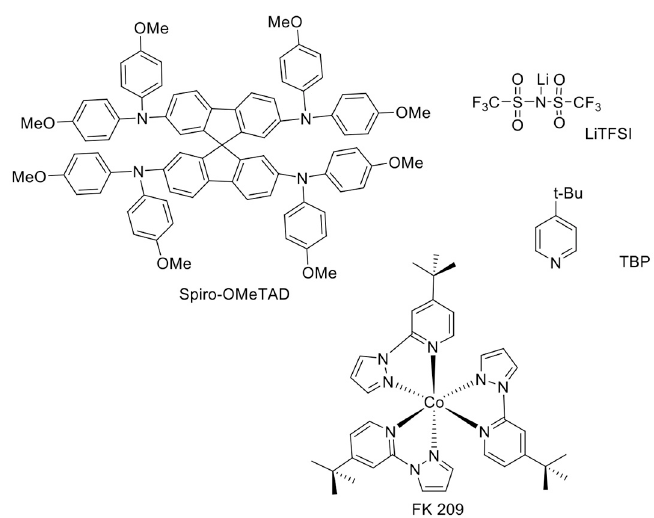
Figure 4. Molecular structures of spiro-OMeTAD, the most widely-used HTM in PSCs, and its dopants (lithium bis(trifluoromethanesulfonyl) imide salt (LiTFSI), 4-tert-butylpyridine (TBP), tris(2-(1 H -pyrazol-1-yl)-4- tert -butylpyridine)cobalt(III) tri[bis(trifluoromethane)sulfonimide] (FK 209).